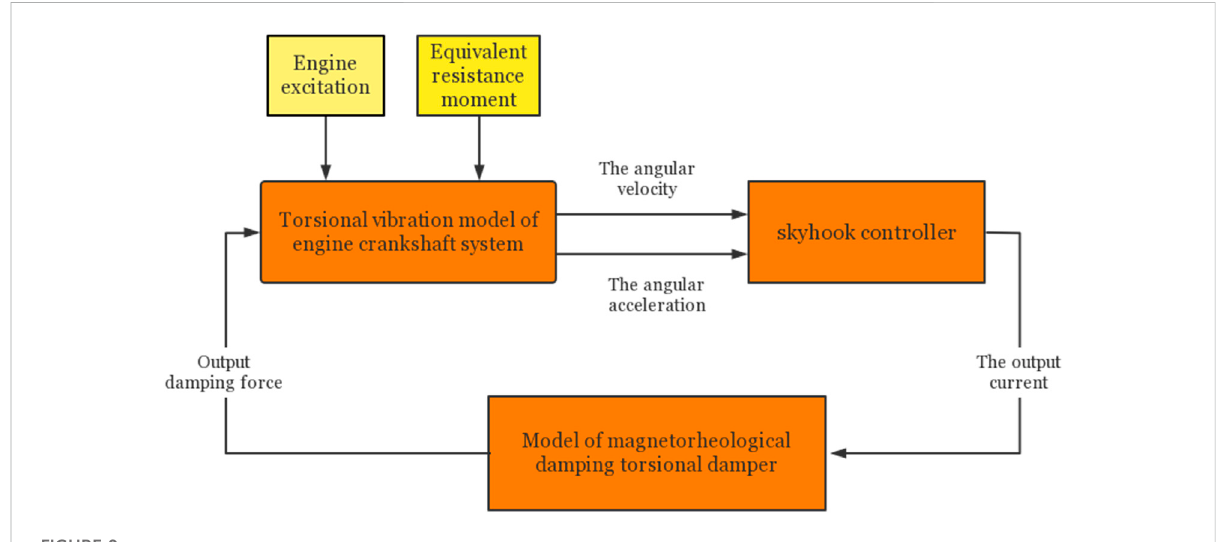
FIGURE 9 Block diagram of crankshaft torsional vibration